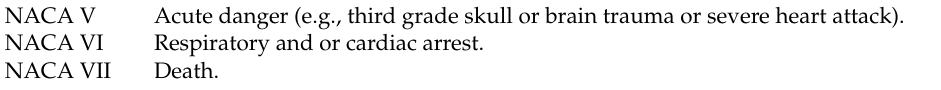
Table 1. Cont. NACA V